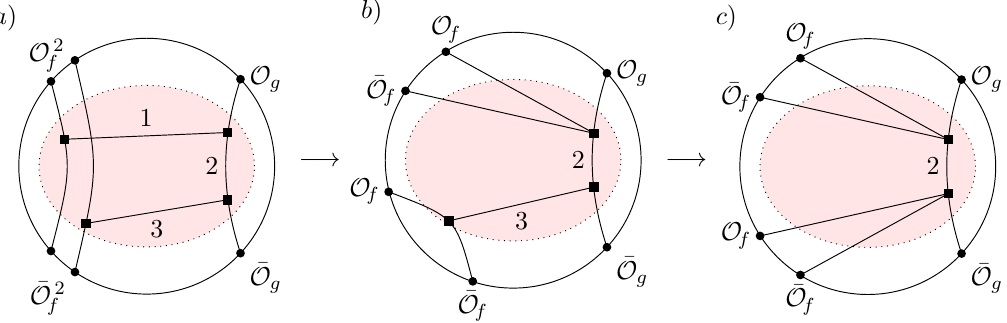
Figure 2 . An example of a connected tree-level Witten diagram contributing to the multi-trace correlator C n =2 with three bulk-bulk propagators which cannot be reduced to a finite sum of contact diagrams using the results of [7]. After two applications of this technique, the remaining bulk-bulk propagator 2 in the rightmost diagram cannot be reduced further due to being connected to three boundary points at each vertex. After each step given, the result will be proportional to a finite sum of such